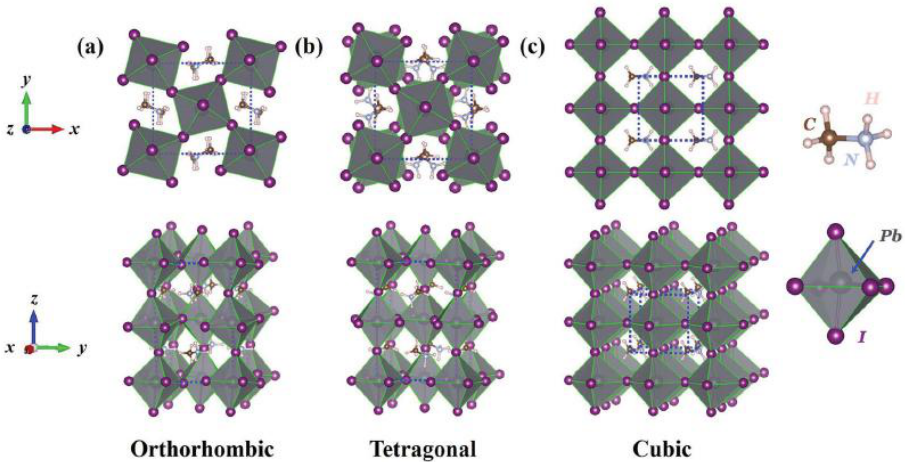
Figure 3. Atomistic configurations of ( a ) orthorhombic; ( b ) tetragonal; and ( c ) cubic phases of perovskite materials. Reproduced with permission [56]. Copyright 2016, Advanced Functional Materials.